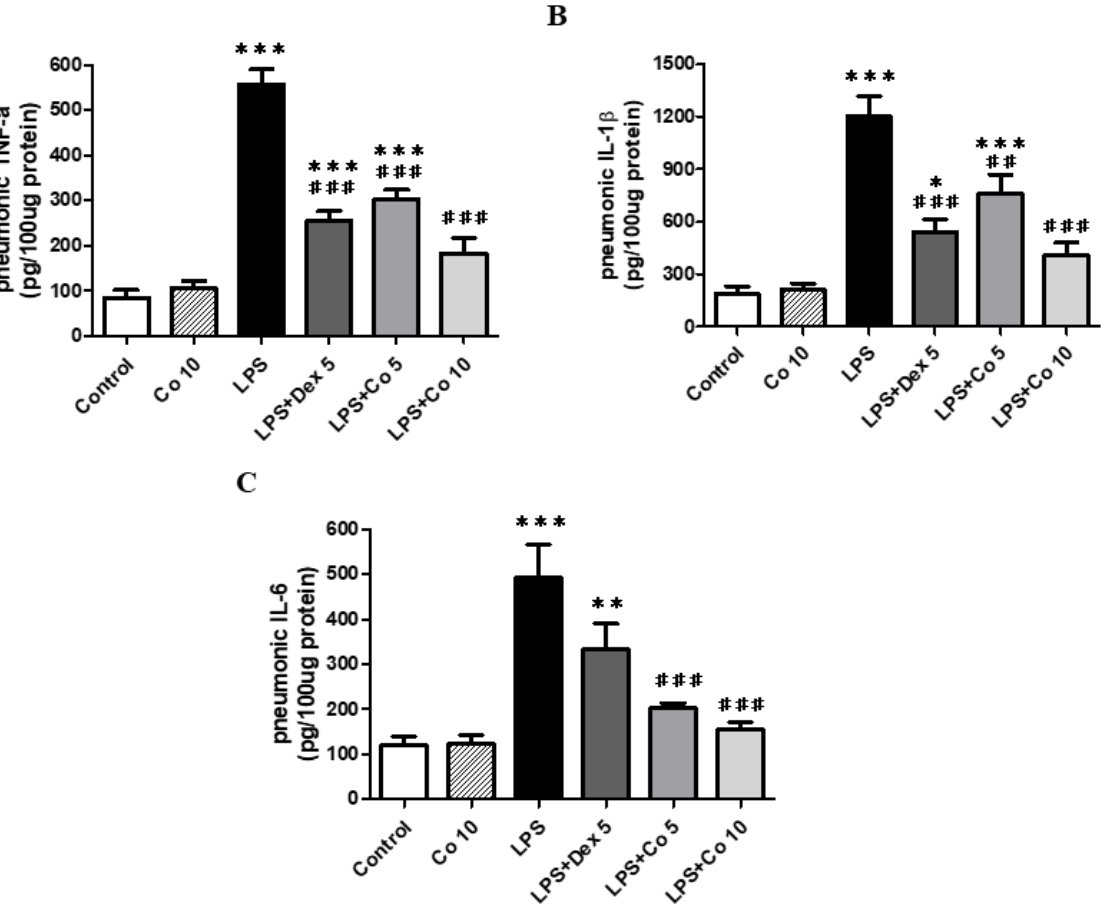
Figure 4. Effects of corilagin on TNF- α (A), IL-1 β (B), and IL-6 (C) expressions in lung tissues . After intratracheal LPS challenge for 30 min, the mice were administered with Dex (5 mg/kg), corilagin (5 and 10 mg/kg), or equal volume of saline intraperitoneally. Mice were sacrificed after 6 h of LPS challenge for analysis of lung TNF- α , IL-1 β , and IL-6 levels. Each value represents mean ± SEM of six mice per group. * p < 0.05, ** p < 0.01, *** p < 0.005 vs. control; ## p < 0.01, ### p < 0.005 vs. LPS alone.